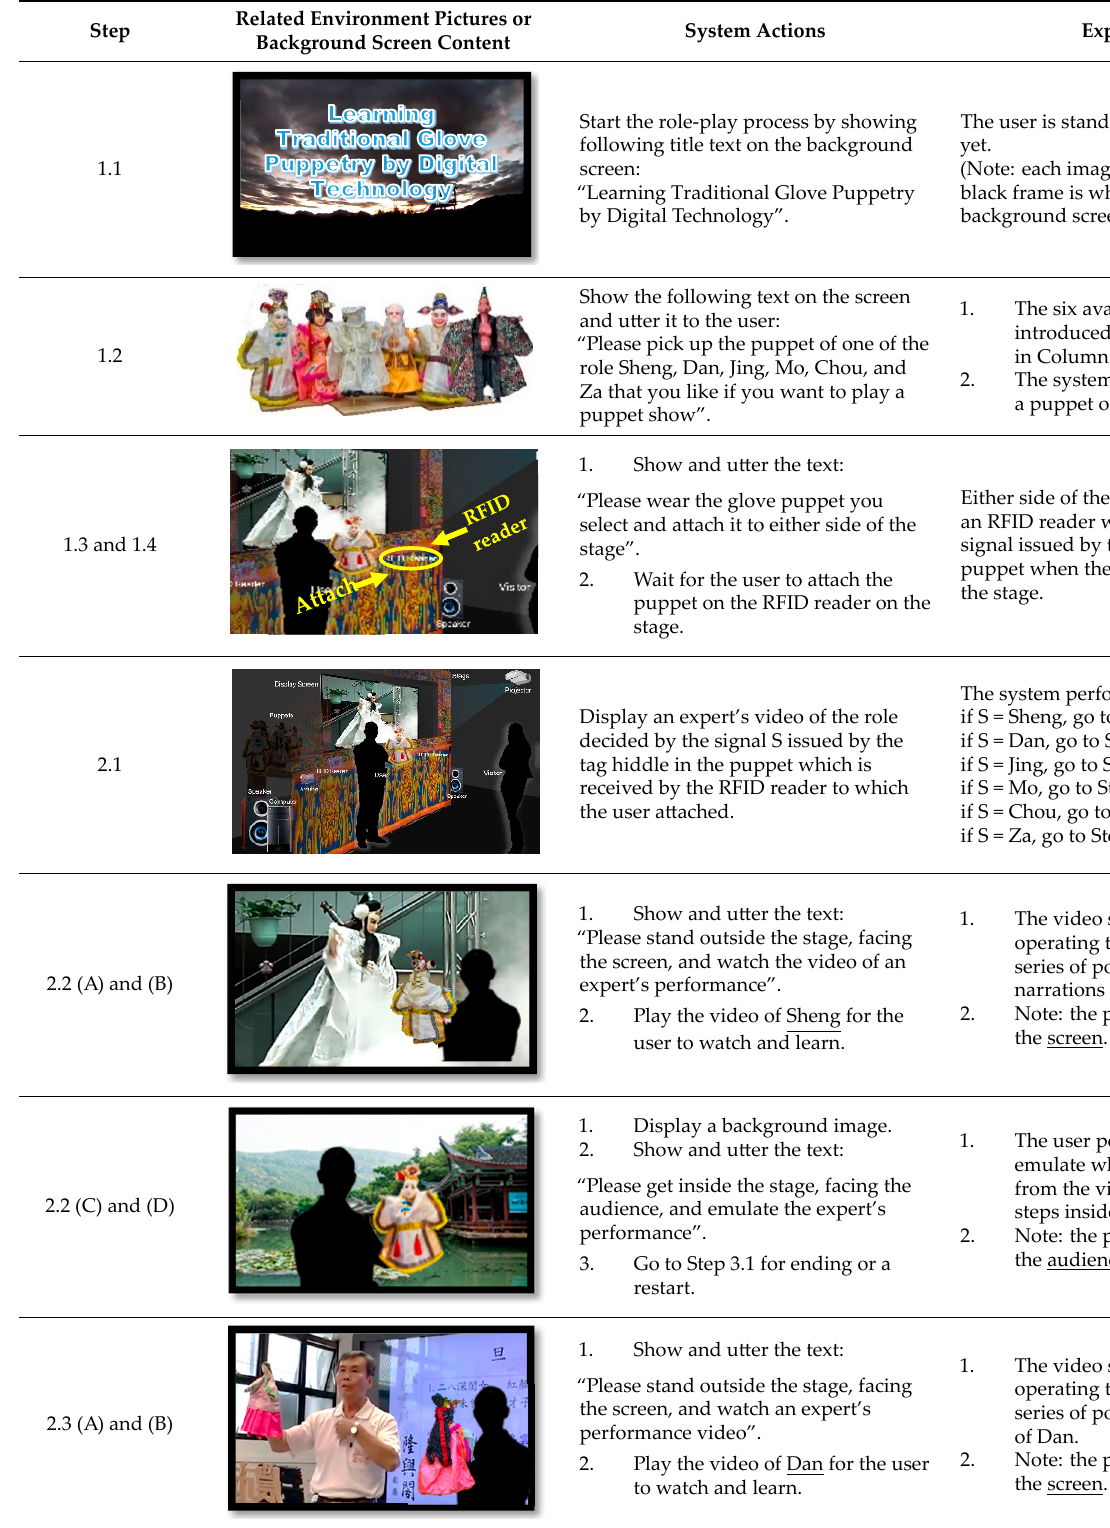
Table 3. The storyboards of the operation process of the puppet show on the proposed system.